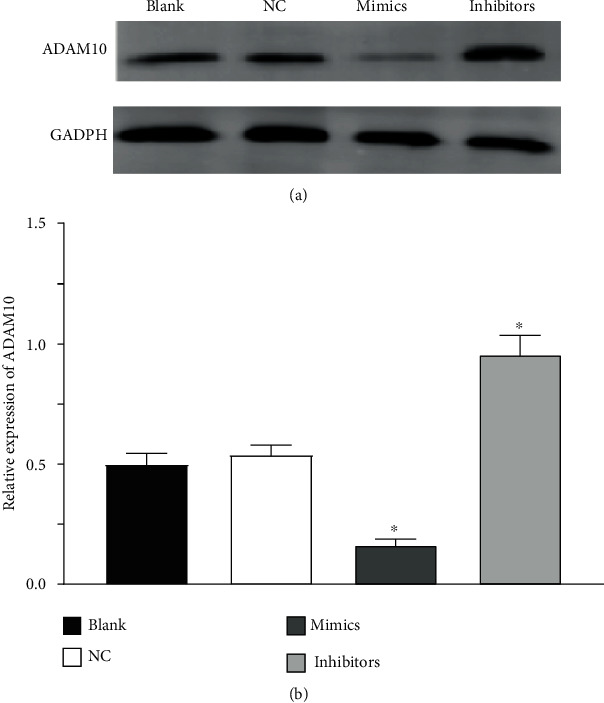
Expression of ADAM10 protein in different cell groups. (a) Western blot of ADAM10 expression in the blank, NC, mimics, and inhibitors groups after transfection of miR-499a-3p for 48 h. (b) Relative expression of ADAM10 in different groups. All results were expressed as the mean ± standard deviation (n = 3).